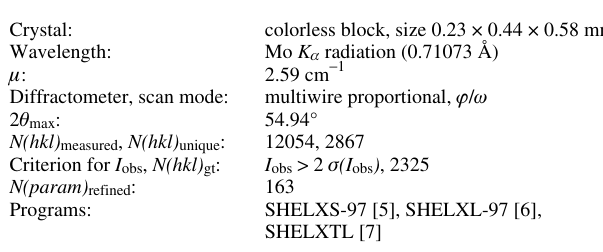
Table 1. Data collection and handling.